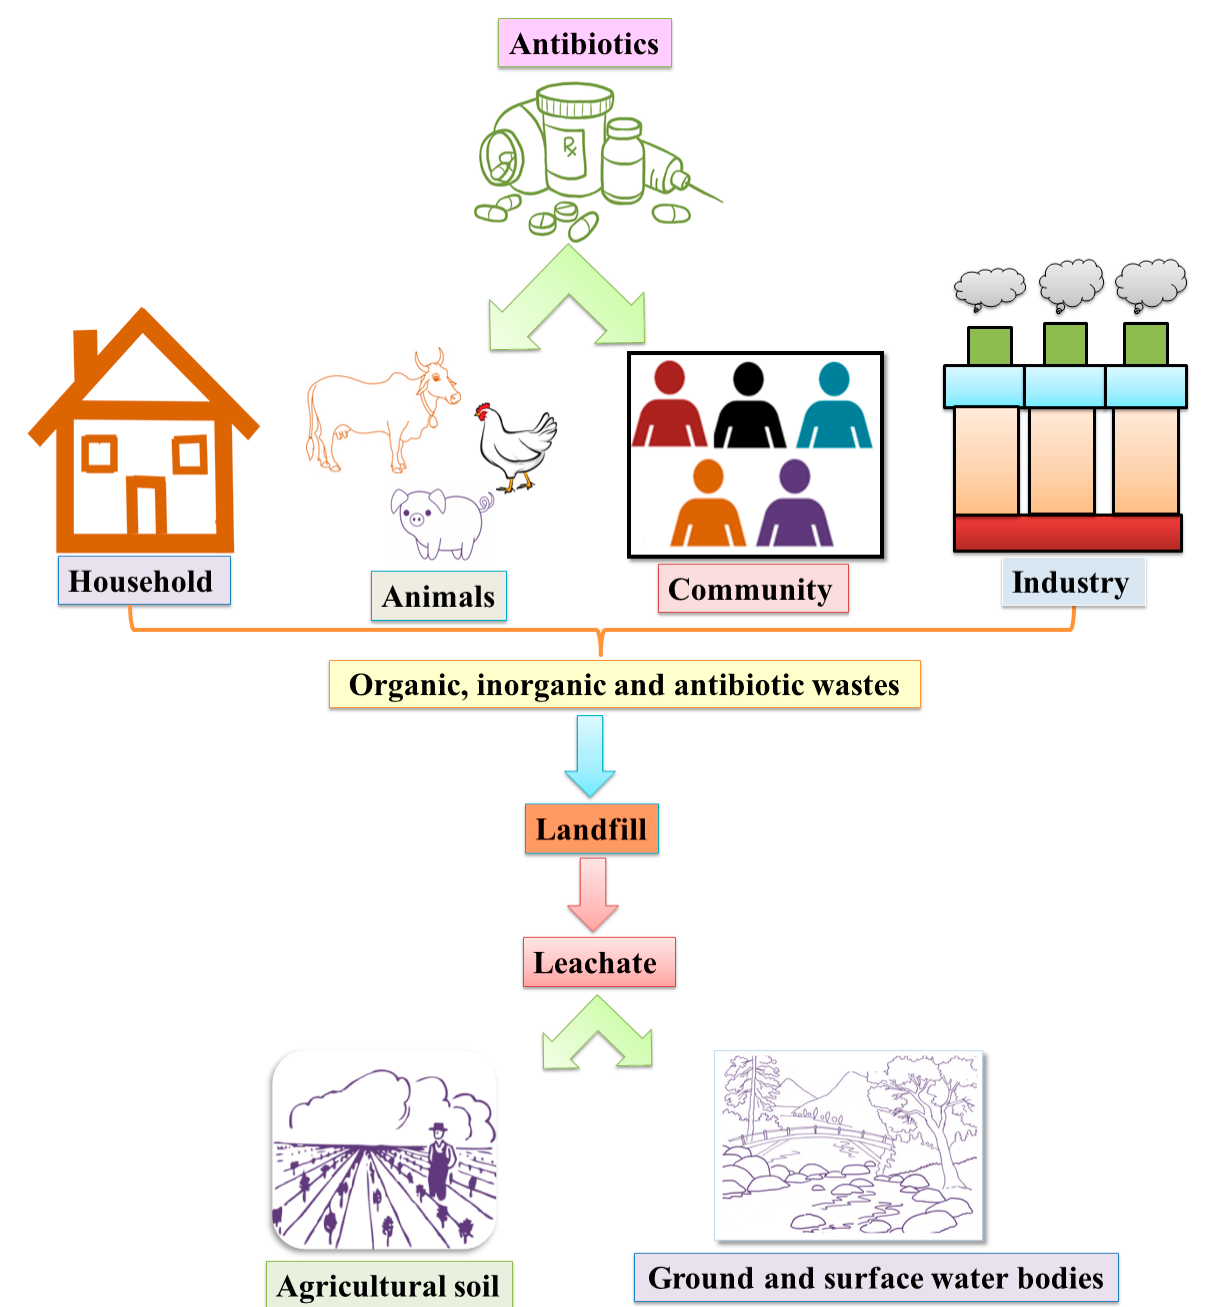
Figure 2. Wastes releases from households, agriculture sites, animal husbandry, and industries accumulate in the municipal solid waste (MSW) landfill, which, finally, affects the surface or groundwater level through leachate percolation. The overall perspective of contaminations through various sources defines the groundwater contaminations in the proposed model.